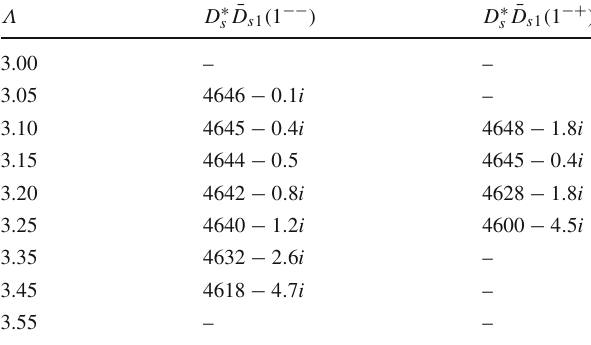
Fig. 3 Thepoleofboundstate(upper)andtheinvariantmassspectrum (lower) from the interaction D ∗ s ¯ D s 1 − D s ¯ D s 1 with J PC = 1 −− at Λ = 3 . 4 GeV. The color means the value of log | 1 − V ( z ) G ( z ) | as shown in the color box Table 2 The bound states from the interaction D ∗ s ¯ D s 1 − D s ¯ D s 1 at different cutoffs Λ in a range from 3.0 to 3.55 GeV. Here, “ − ” means that no bound state is found or the bound state has a binding energy larger than 50 MeV. The cutoff Λ and position of the pole z are in units of GeV and MeV, respectively